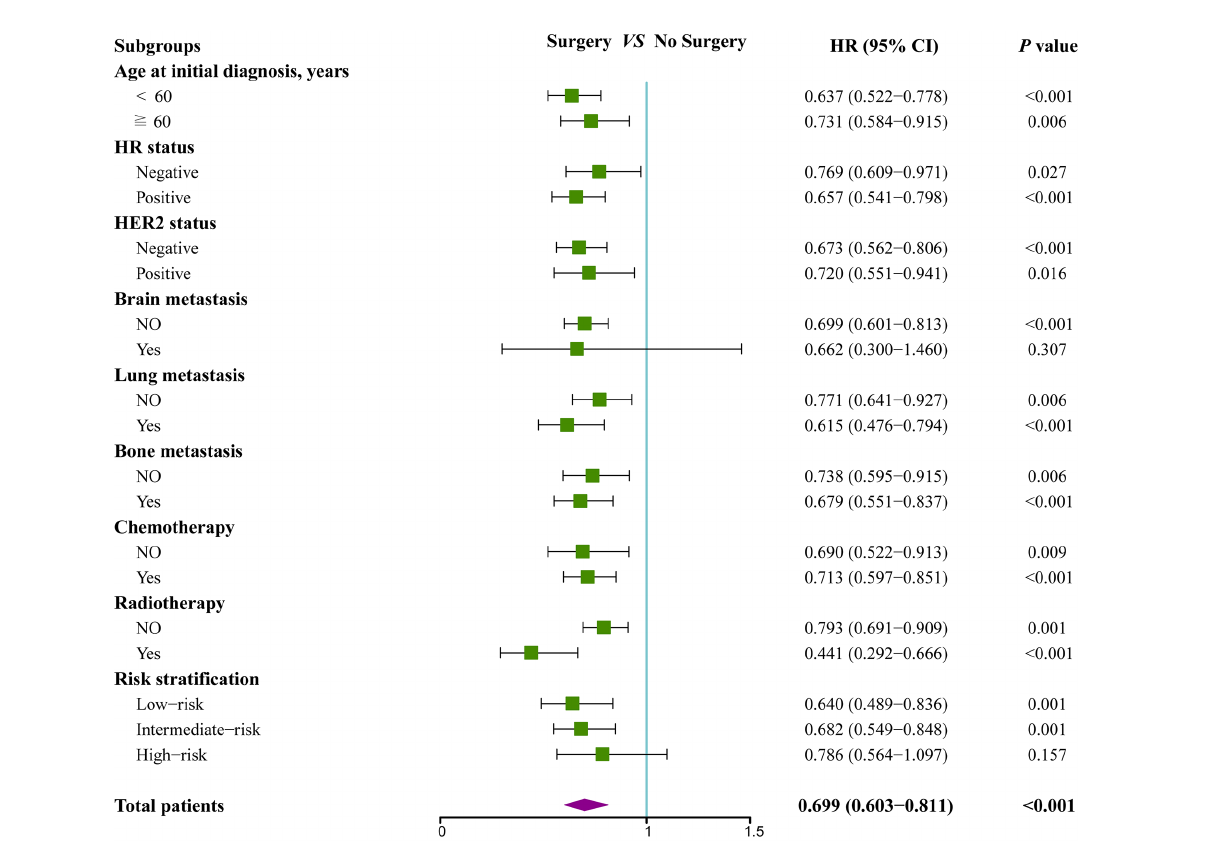
FIGURE 5 | Subgroup analysis of overall survival for patients who received locoregional treatment or